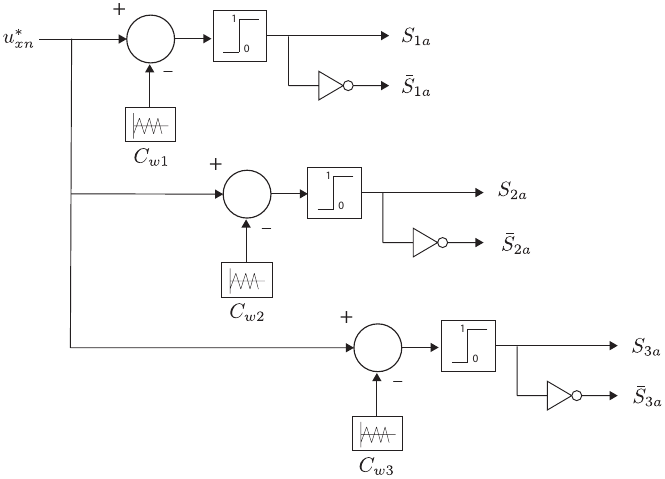
Figure 4. Implementation of the LS-PWM scheme.